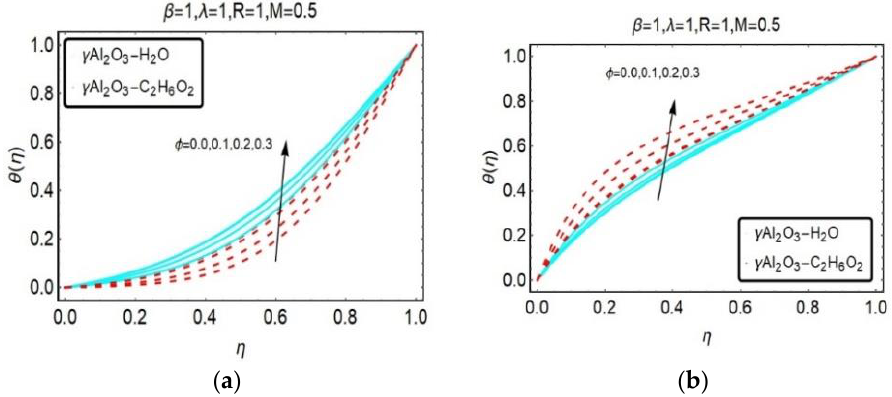
Figure 19. Influence of 𝜆 on 𝜃(𝜂) for ( a ) 𝑆 > 0 and ( b ) 𝑆 < 0.